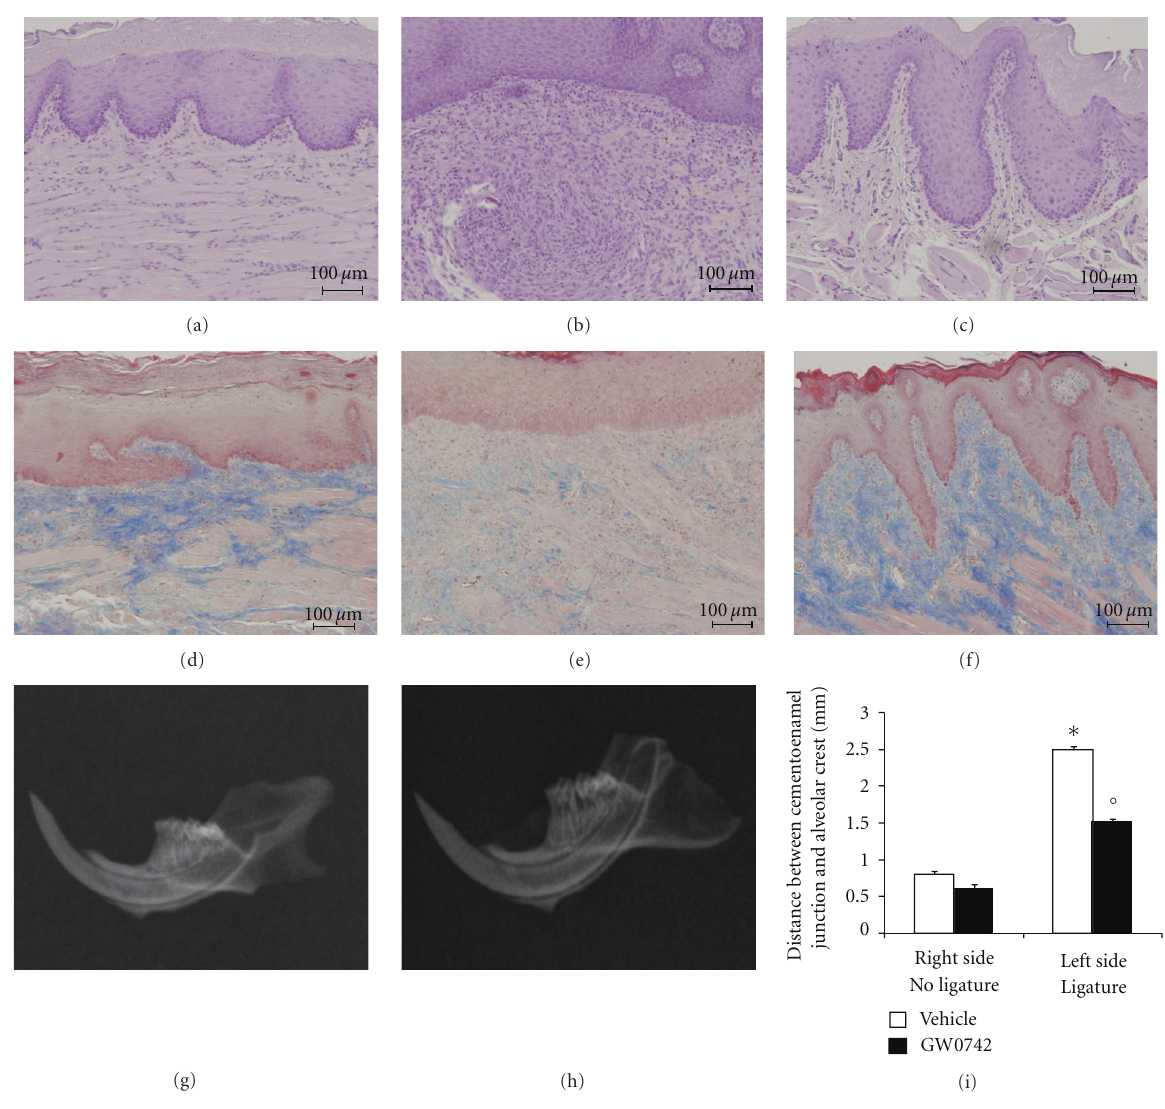
Figure 1: E ff ect of GW0742 on tissue damage and bone resorption. Inflammatory cells infiltration and edema were observed in gingivomucosal section from ligated rats (b) when compared with gingivomucosal tissue section taken from contralateral side (a). Significantly less edema and inflammatory cell infiltration was observed in gingivomucosal sections from ligature-treated rats which had been treated with GW0742 (c). Moreover, Masson’s trichrome stain was negative in gingivomucosal tissue sections taken from the contralateral side of vehicle when compared with gingivomucosal tissues sections of ligature-operated rats (d, e, resp.). GW0742 treatment reduced the increase of collagen (f). The alveolar bone from ligated rats demonstrated alveolar bone resorption (g). GW0742 treatment suppressed alveolar bone resorption (h). A significant increase in the distance between cementoenamel injunction and alveolar crest at mediolingulal root of the first molar was observed in ligature-treated rats (i). GW0742 treatment significantly reduced the increase in the distance between cementoenamel injunction and alveolar crest (i). Figures are representative of at least 3 experiments performed on di ff erent experimental days. The tissue sections, orientated longitudinally from the teeth crown, were stained with trichrome stain. Data represent 20 counts obtained from the gingivomucosal tissue of each treatment group. ∗ P < 0 . 01 versus nonligated. ◦ P < 0 . 01 versus